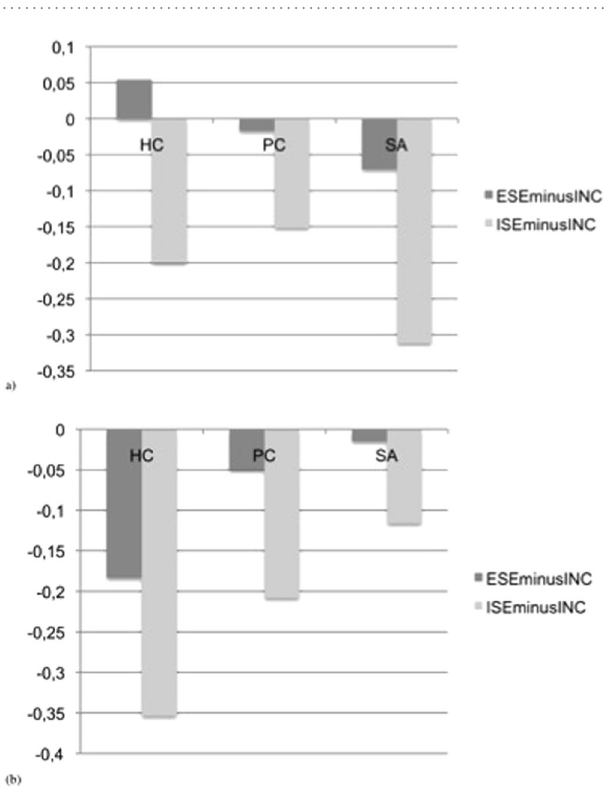
Figure 2. Comparison of brain activation between the three groups for the explicit exclusion (ESE) vs. inclusion (INC) conditions contrast. Significant group x condition differences in supramarginal gyrus at − 39